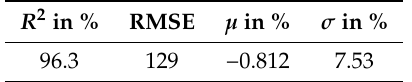
Figure 9. Absolute and relative distribution of the residuals between predicted Nusselt numbers Nu and measured global Nusselt numbers Nu .